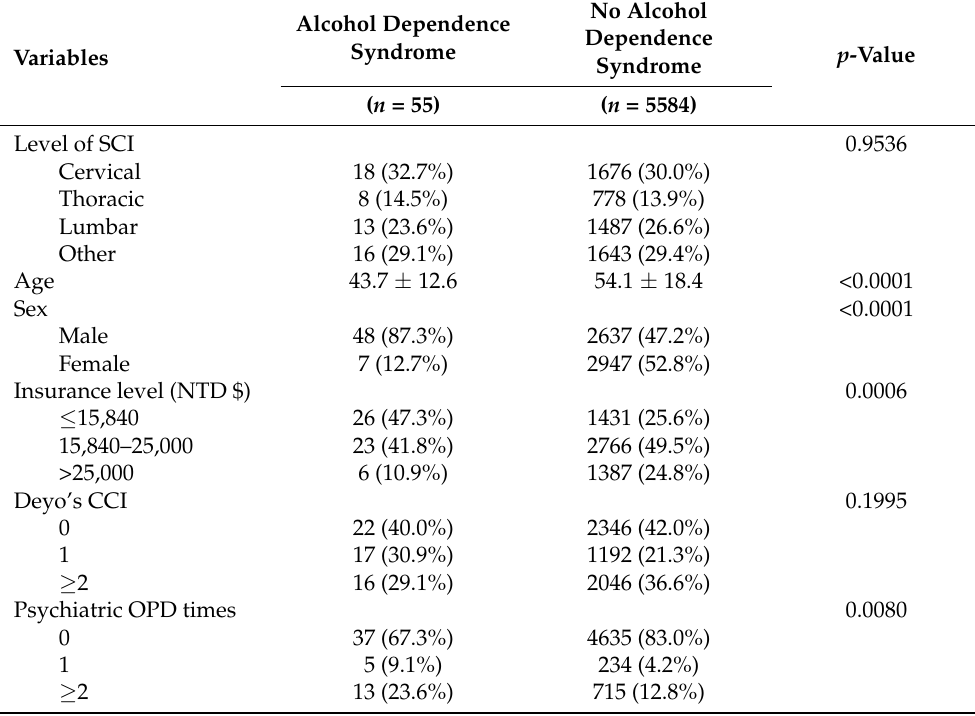
Table 2. Distribution of the subjects with alcohol dependence syndrome in the study